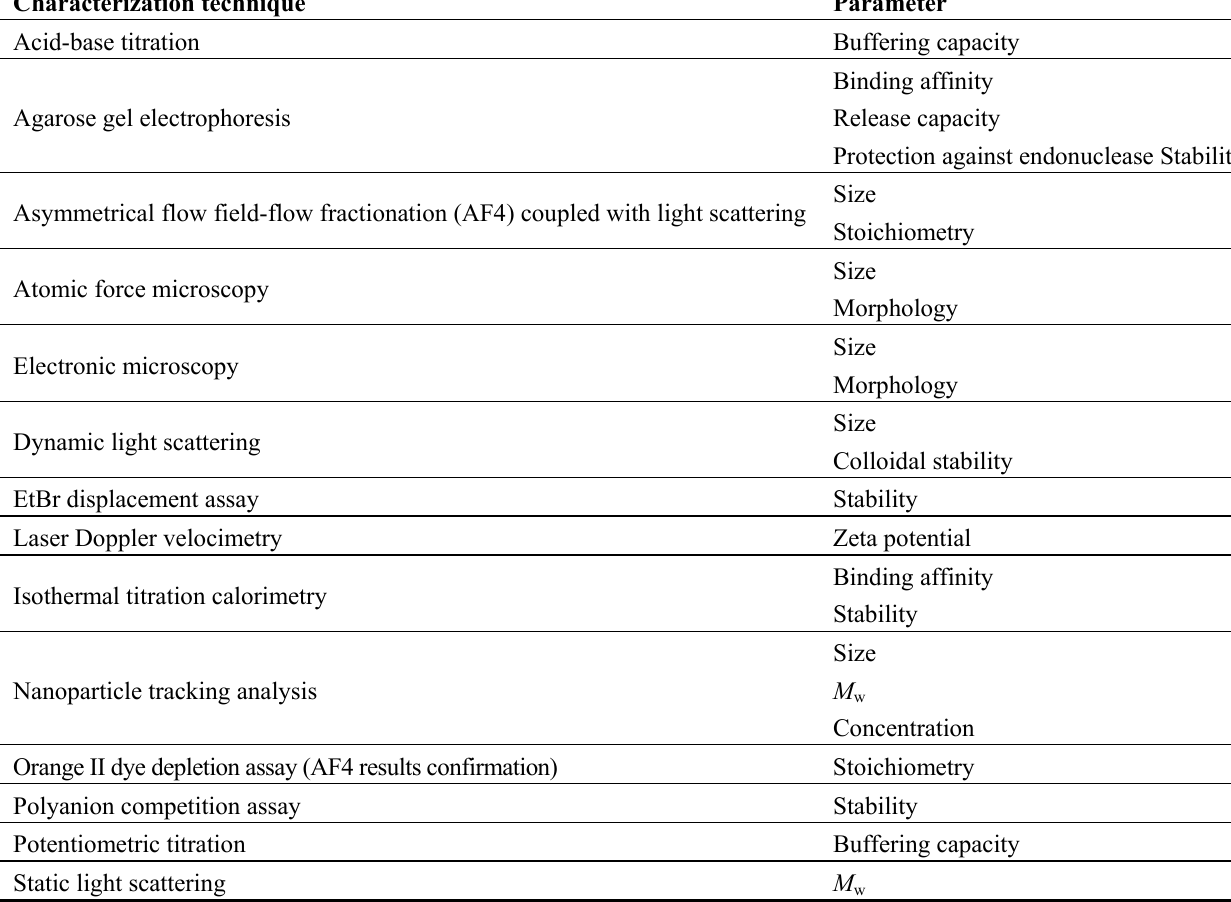
Table 1. Characterization methods of low molecular weight chitosan (LMWC)/pDNA polyplexes. Characterization